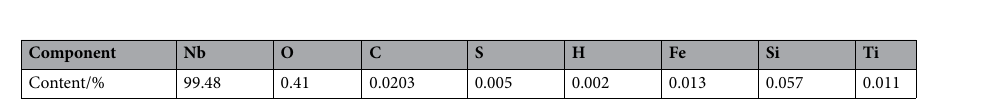
Table 2. Chemical composition of niobium